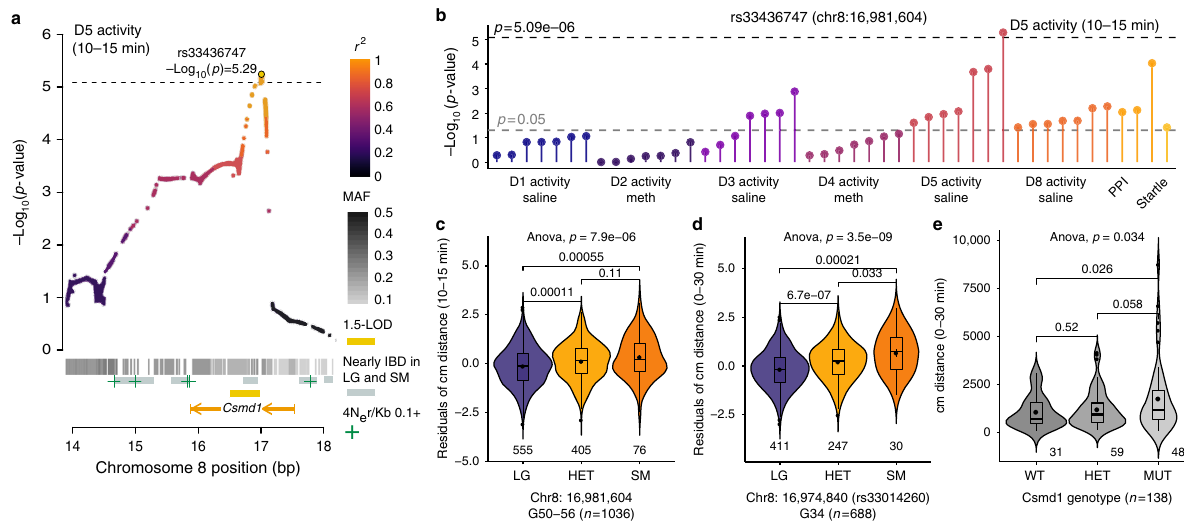
Fig. 4 Replication of an association between Csmd1 and locomotor activity. a Regional plot drawn from the full set of 4.3 million unpruned SNPs showing the association between rs33436747 and D5 activity levels (12,058 SNPs are plotted for this region). The location of Csmd1 , 1.5-LOD interval (gold bar), areas of elevated recombination 79 (green plus symbols), regions predicted to be nearly IBD between LG and SM 21 (gray bars), and SNP MAFs (gray heatmap) are indicated. Points are colored by LD ( r 2 ) with rs33436747 The dashed line indicates a signi fi cance threshold of − log 10 (p) = 5.09 ( α = 0.05; likelihood ratio test). b PheWAS plot of associations between rs33436747 and other behavioral traits measured in G50 – 56 mice. Violin plots in ( c – e ) display the interquartile range with the median plotted as a horizontal line and the mean plotted as a point. P -values from ANOVA and two-sided t -tests are shown for each comparison. c Violin plot of quantile-normalized residuals of locomotor activity at the Csmd1 locus are plotted for G50 – 56 mice (ANOVA p = 7.85e − 06; F = 11.89; df = 2, 1033). For each comparison, LG vs. SM p = 5.52e − 04, t = − 3.58, df = 94.34; LG vs. HET p = 1.11e − 04, t = − 3.88, df = 890.44; SM vs. HET p = 0.108, t = 1.62, df = 99.56. d Violin plot of quantile-normalized residuals of locomotor activity at the Csmd1 locus for G34 mice 13 (ANOVA p = 3.51e- − 09; F = − 20.03; df = 2, 685). For each comparison, LG vs. SM p = 2.11e − 04, t = − 4.17, df = 32.45; LG vs. HET p = 6.72e − 07, t = − 5.03, df = 521.27; SM vs. HET p = 0.033, t = 2.22, df = 34.73. rs33436747 was not genotyped in G34; therefore, we plotted activity by genotype at the nearest